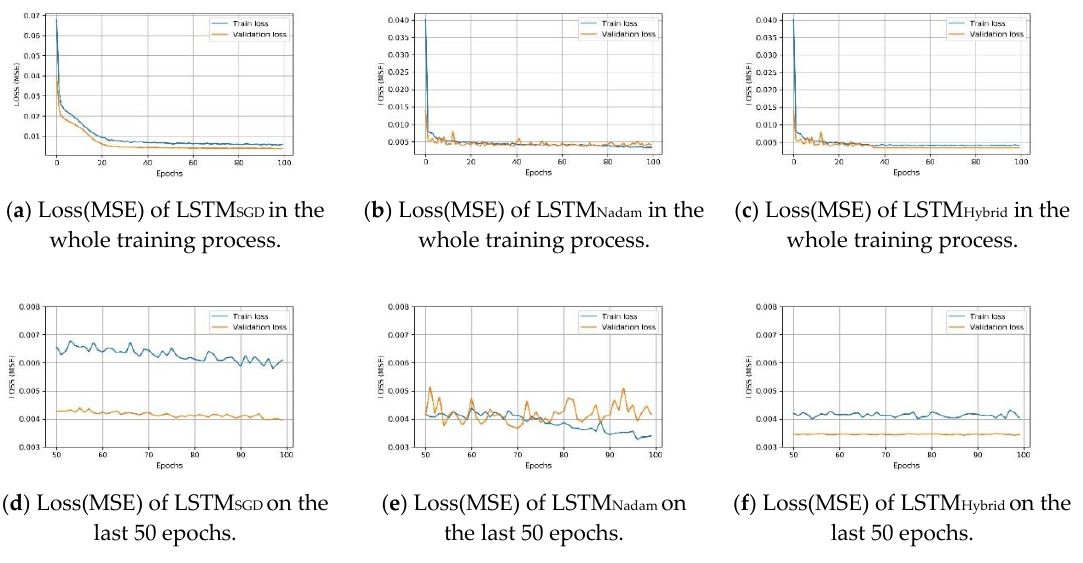
Figure 11. Loss (MSE) of LSTM SGD , LSTM Nadam and LSTM Hybrid models.